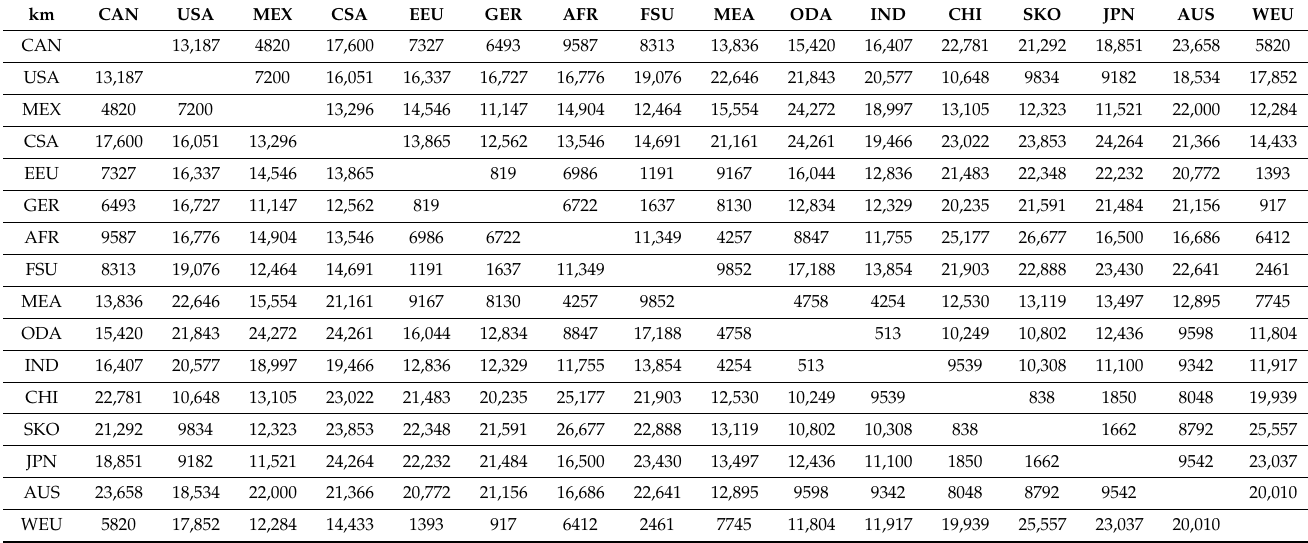
Table A1. Distance matrix for shipping based on [58].